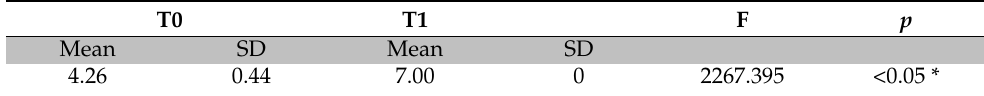
Table 2. Effect of within factor on task 1